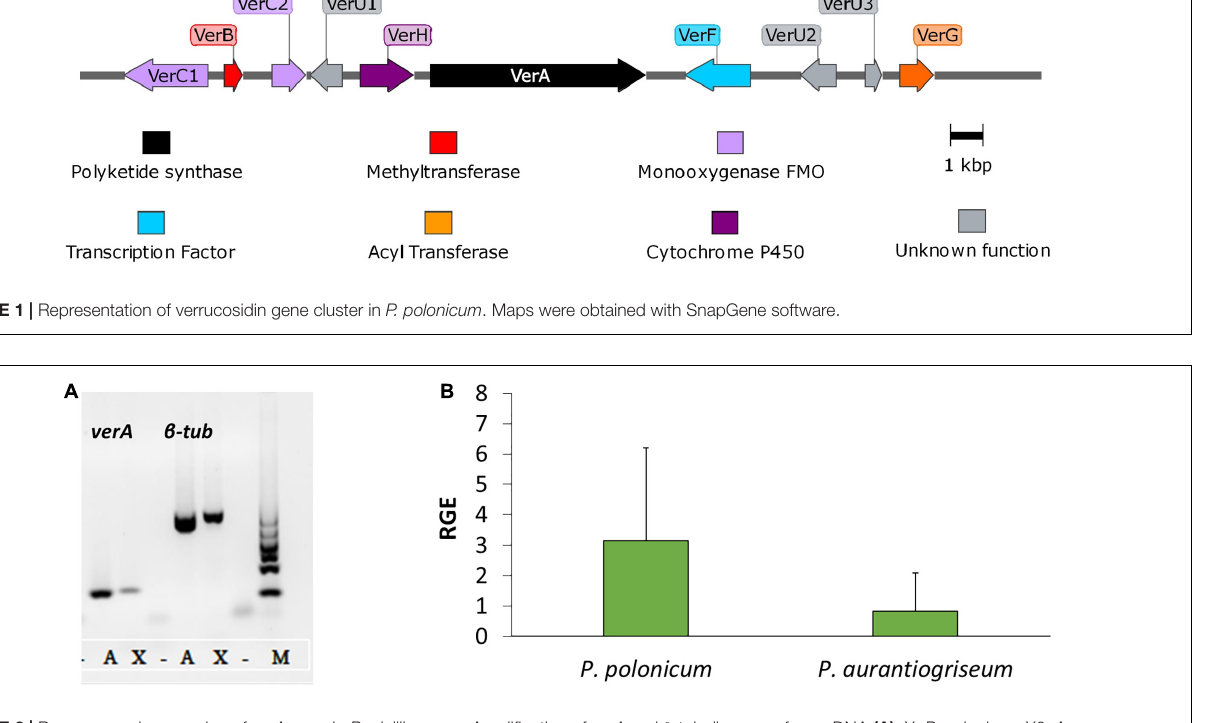
Frontiers in Microbiology |